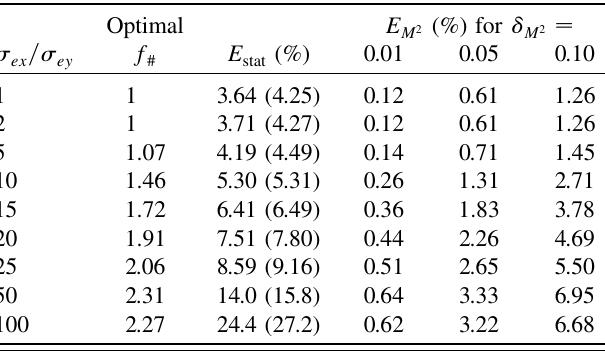
) for the measure- stat (cid:1) ey (cid:1) 1 (cid:3) m and (cid:2) (cid:1) 25 (cid:3) m . For Fig. 15 for the case of (cid:2) ey ex each set of (cid:2) , (cid:2) , there is an optimal f -number that ex ey